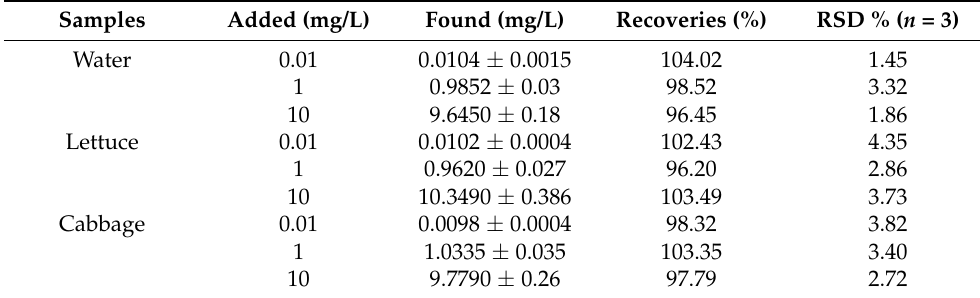
Table 2. Detection of PQ in real